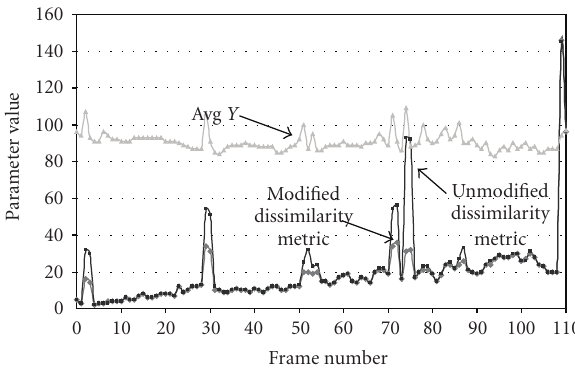
Figure 2: Variations of the average Y per MB, unmodified dissimilarity metric, and modified dissimilarity metric by Δ Y parameter, for a test video sequence, due to flashing light